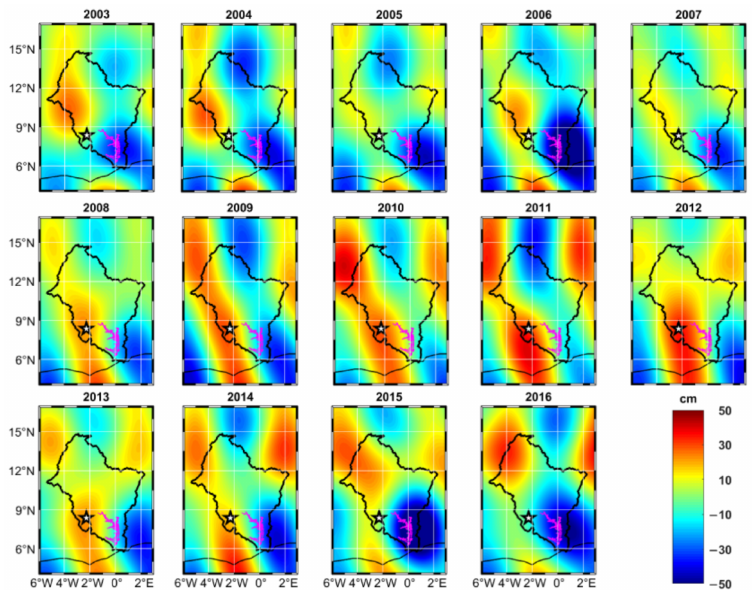
Figure 8. Multi-year averages of raw GRACE estimated mass changes in SeptemberNovember from 2003 to 2016 with seasonal variations removed. All the plots have been deduced from the mean of the first 4 months in 2012. The location of the Bui Reservoir is marked with a white star. The pink area represents the Volta